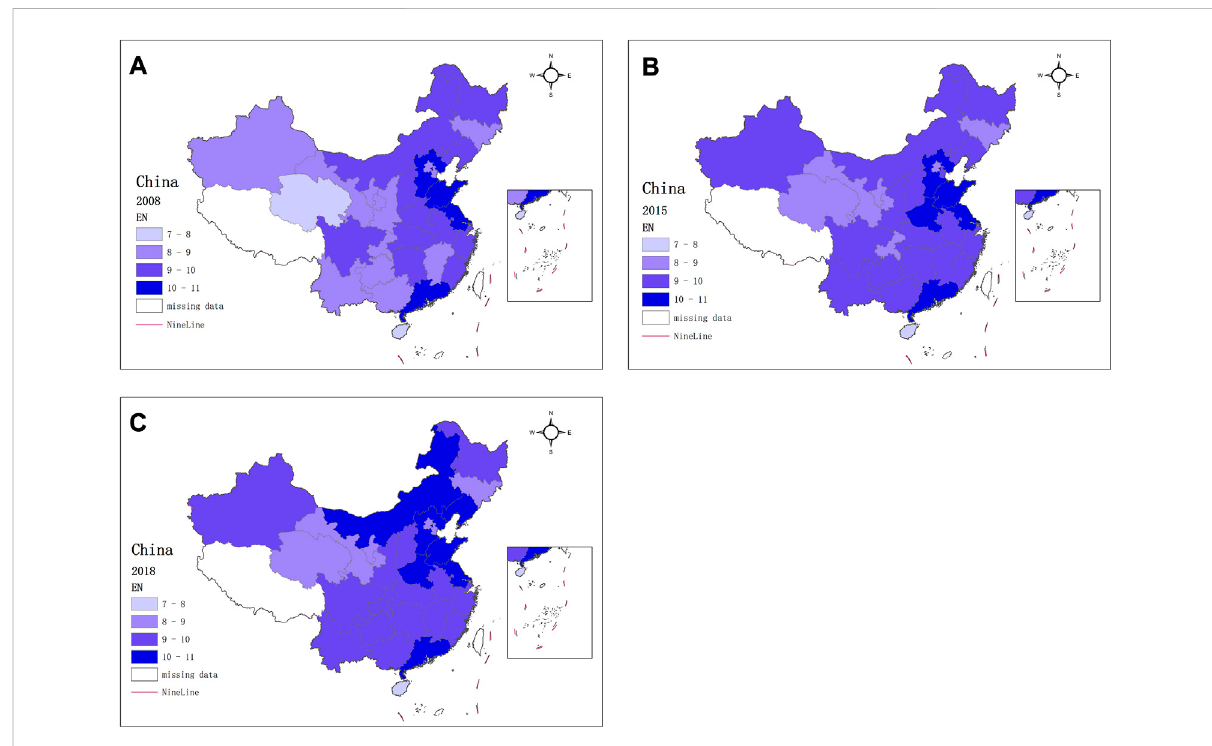
FIGURE 5 Spatial and temporal evolution of energy